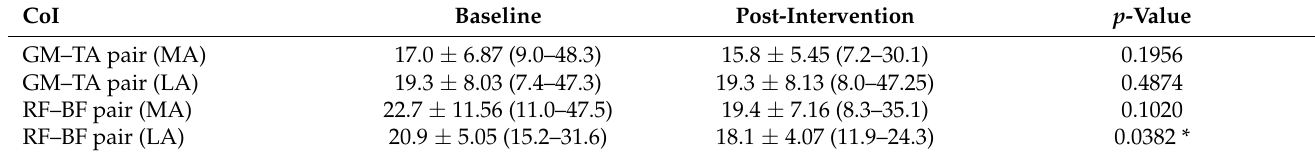
Table 3. Pre- and post-training co-activation index.